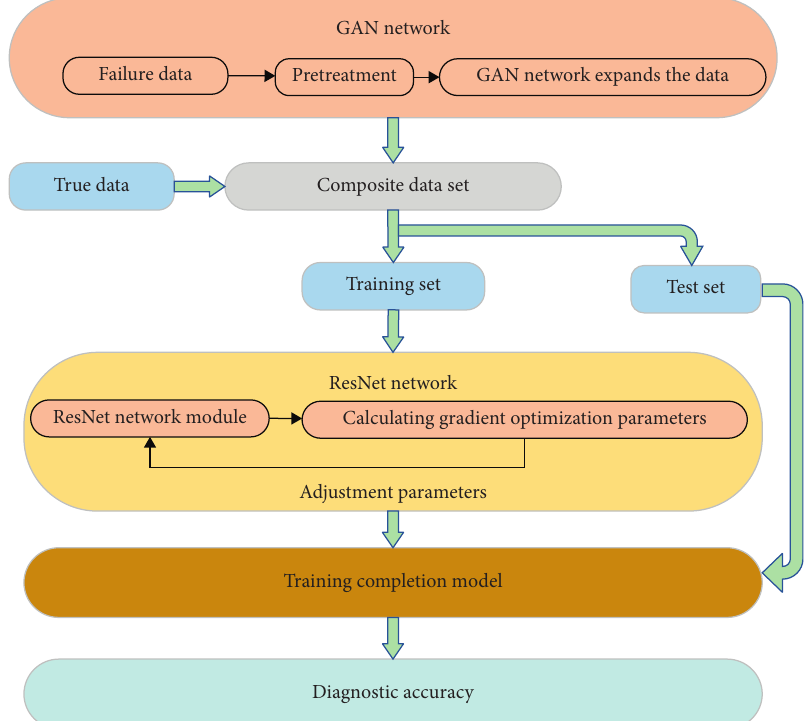
Figure 4: Diagnostic flowchart for track fasteners.